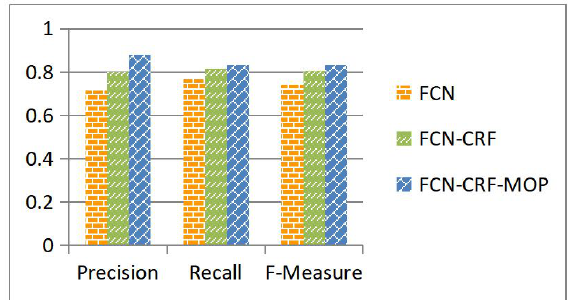
Figure 7. A performance comparison of the existing FCN and FCN-CRF models and our proposed FCN-CRF-MOP model with respect to corner